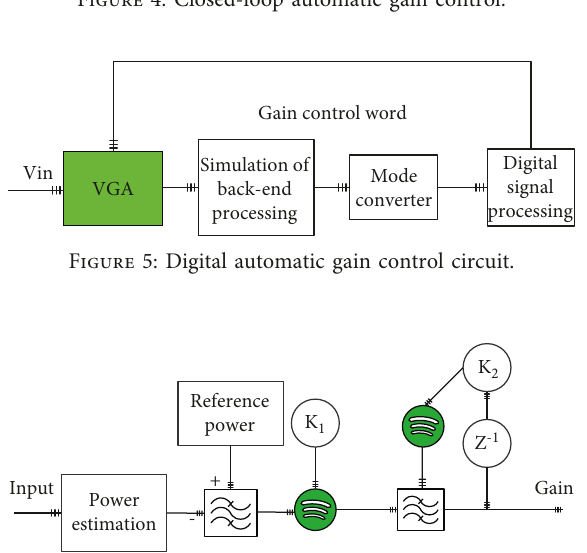
Figure 4: Closed-loop automatic gain control.